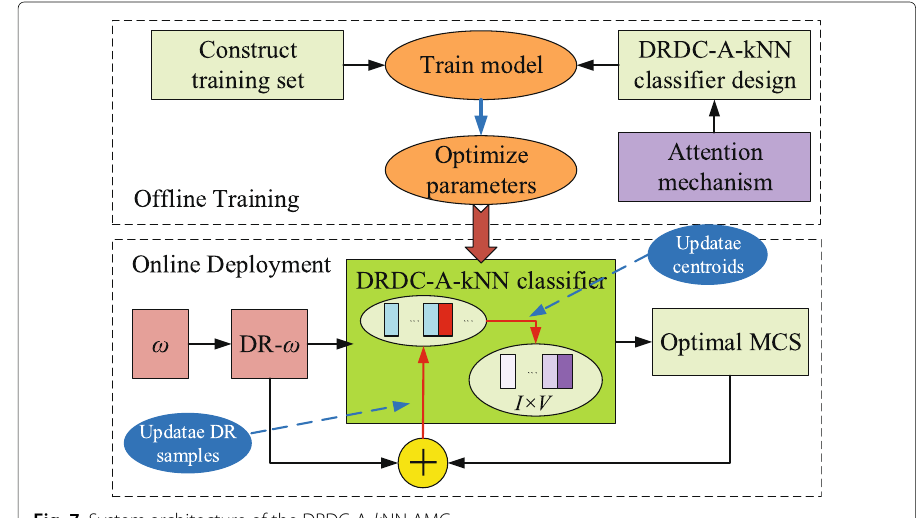
Fig. 7 System architecture of the DRDC-A- k NN